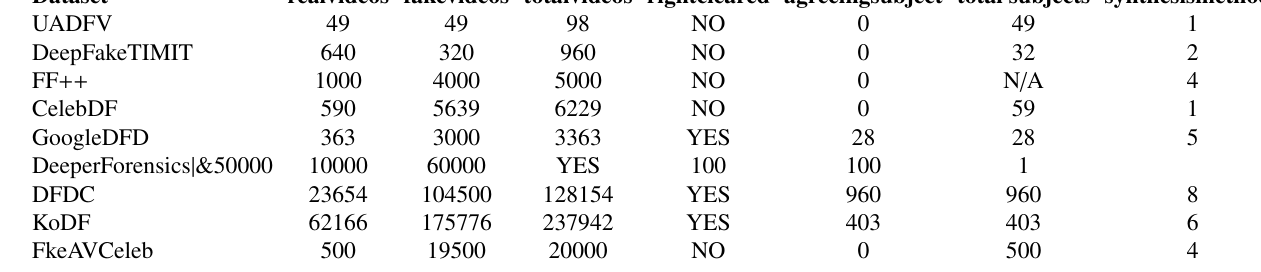
Table 1. Quantitative comparison of fakeAVCeleb to existing publically available deepfake dataset